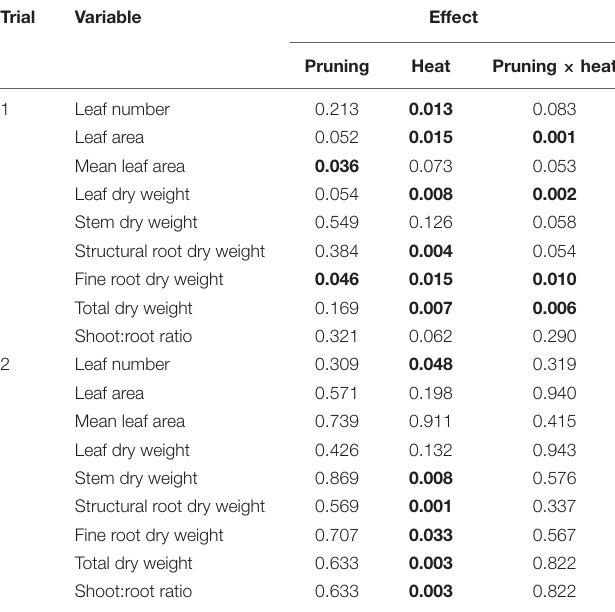
TABLE 1 | P -values of plant dry-weight variables at the end of each of two trials of heat treatment and defoliation. Trial Variable